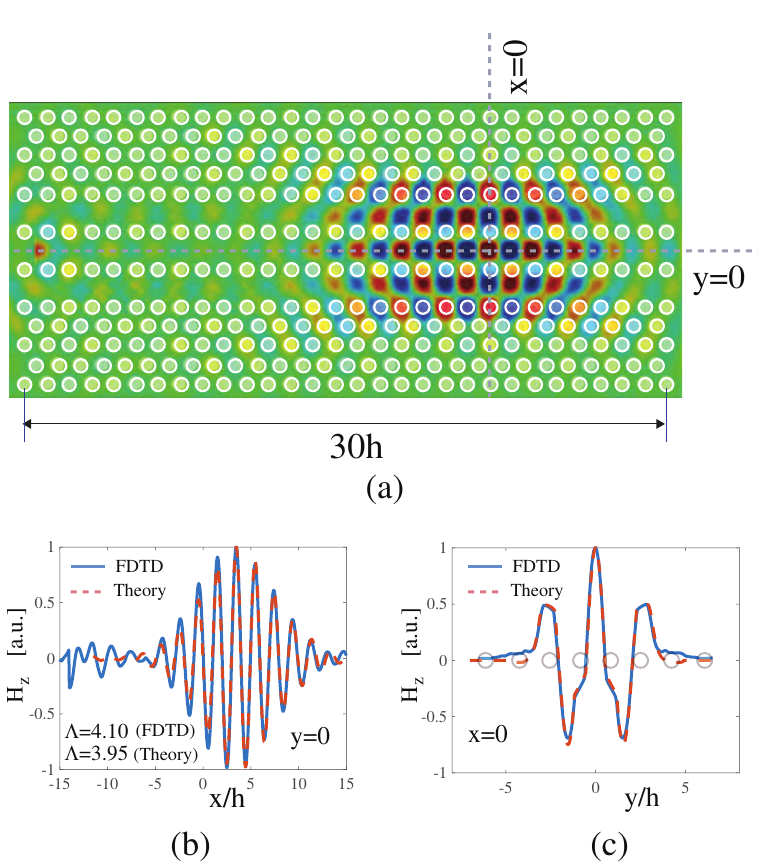
Figure 3. ( a ) The magnetic field of the gap soliton when a continuous signal with the peak power = 0.1410 is injected into the guiding region ( b ) . The operating frequency is h ω χ ( 3 ) E 2 0 (Figure 1). ( b ) Magnetic field distribution H z versus the non-dimensional parameter x / h at y = 0 (Figure 3a), where the blue line shows the numerical result based on FDTD analysis, while the red dashed line represents the result using Equation (1) together with Equations (6)–(11), (16) and (17). ( c ) Magnetic field H z versus y / h at x = 0 (Figure 3a), where the blue line represents the numerical result based on FDTD analysis and the red dashed line shows the theoretical analysis based on Equation (1) together with Equations (6)–(11). Here [a.u] stands for arbitrary units. Reprinted from Ref.